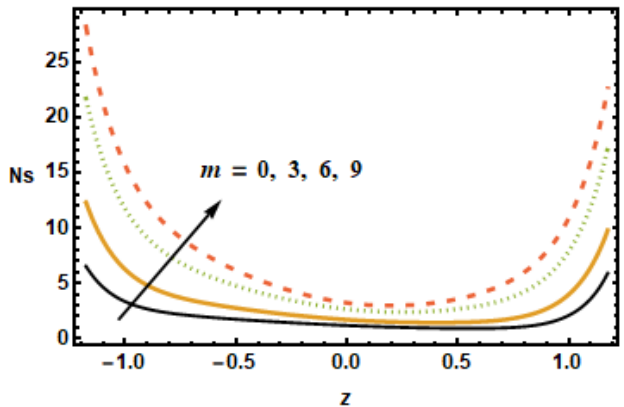
Figure 20. Effects of Hall parameter m on Ns .